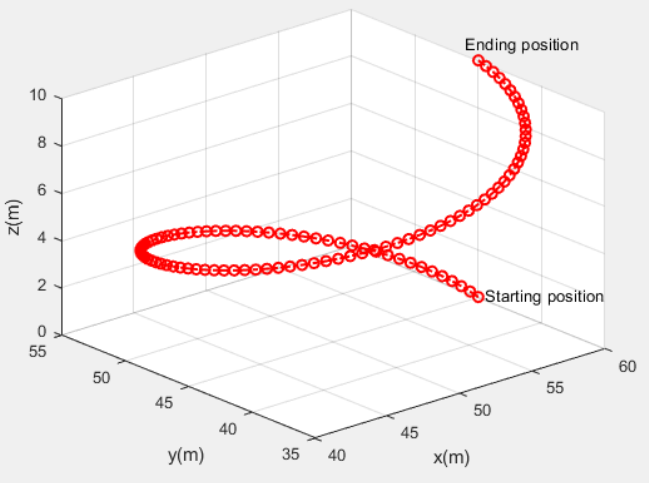
Figure 4. MCTDIs within the workspace: ( a ) (cid:60) A on the plane y = 45 m, ( b ) (cid:60) A on the plane x = 50 m.